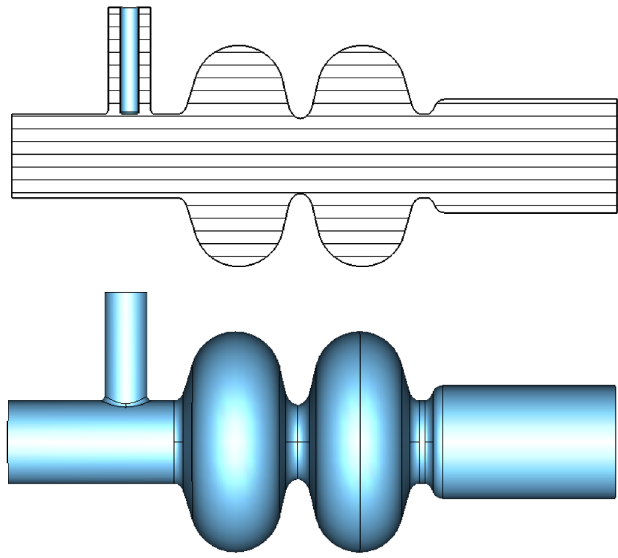
FIG. 1. (Color) Two cell model of the seven cell TESLA-type Cornell ERL superconducting rf cavity.